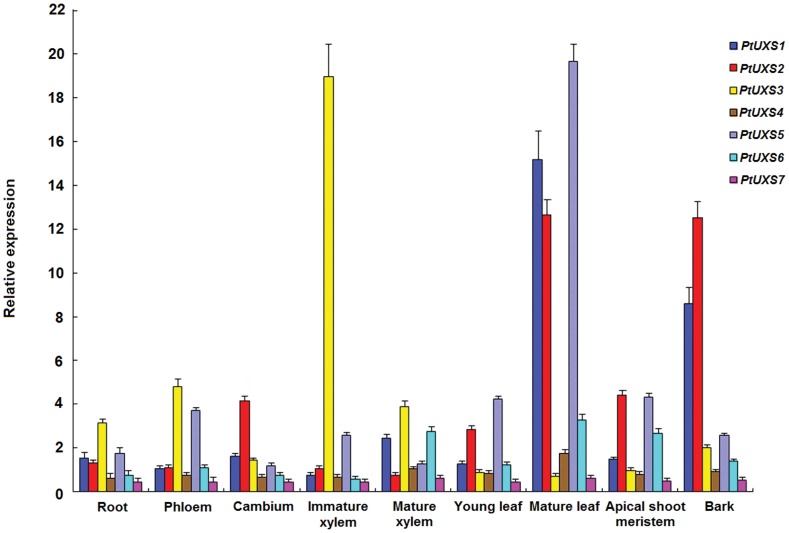
Relative transcript levels of seven PtUXS family members in different tissues and organs.Transcript levels were measured in different tissues, as indicated, by quantitative RT-PCR and is normalized to expression of Actin. Error bars represent+SD.